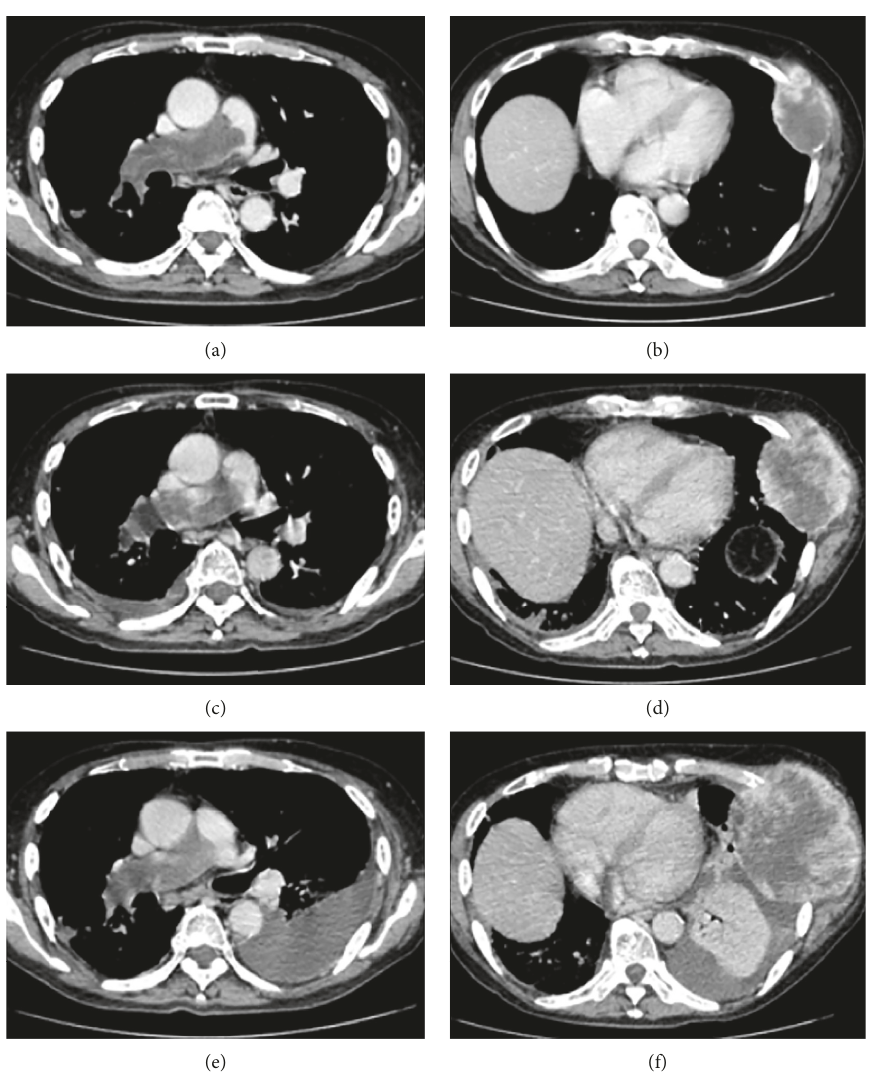
Figure 2: Chronological progression of the tumors on chest computed tomography. Computed tomography cross sections of the right pulmonary artery and chest wall tumor levels were shown at 4 (a, b), 8 (c, d), and 9 months (e, f) from the initial visit. The tumor expansively occupied the entire lumen of the right pulmonary artery, and the chest wall tumor drastically enlarged over time, with a massive left pulmonary effusion appearing at 9